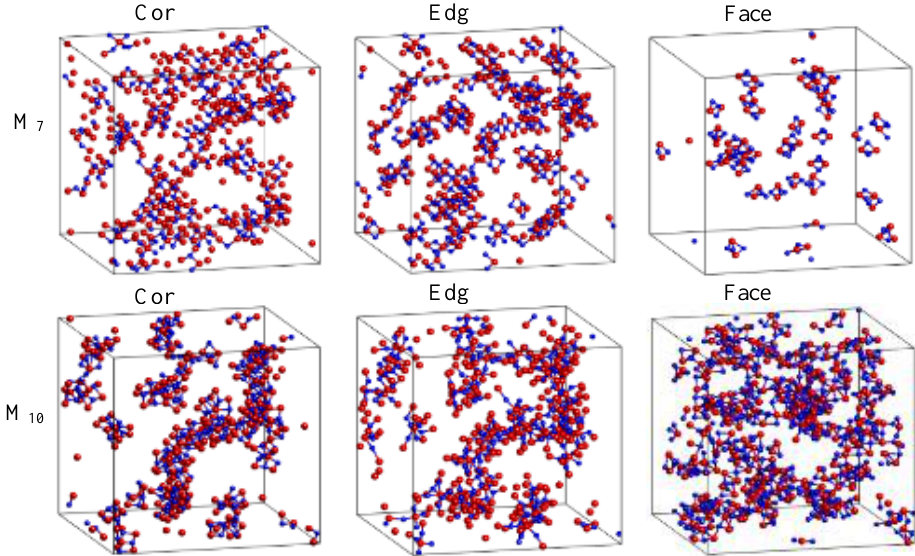
Figure 10. Distribution of corner, edge, face-sharing of Al 2 O 3 at pressure of 5, 15, 30 and 80 GPa and 3500 K. Al and O atoms are in red and blue color, respectively